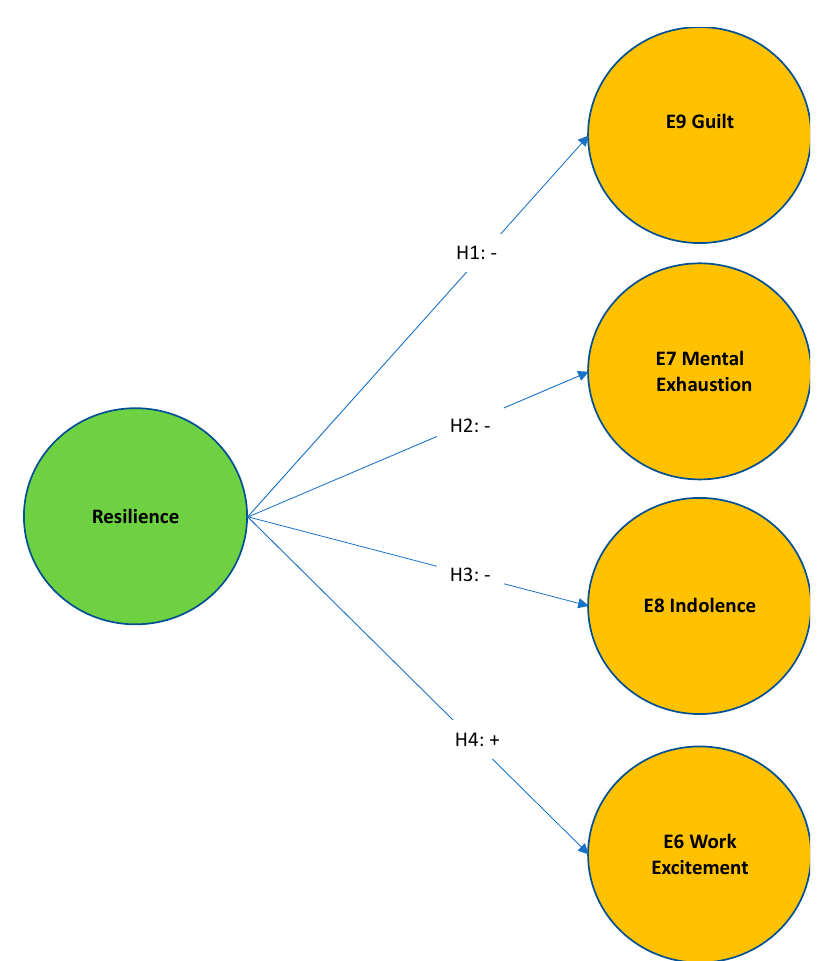
Figure 2. Ex-Ante Model. Source: Own elaboration.